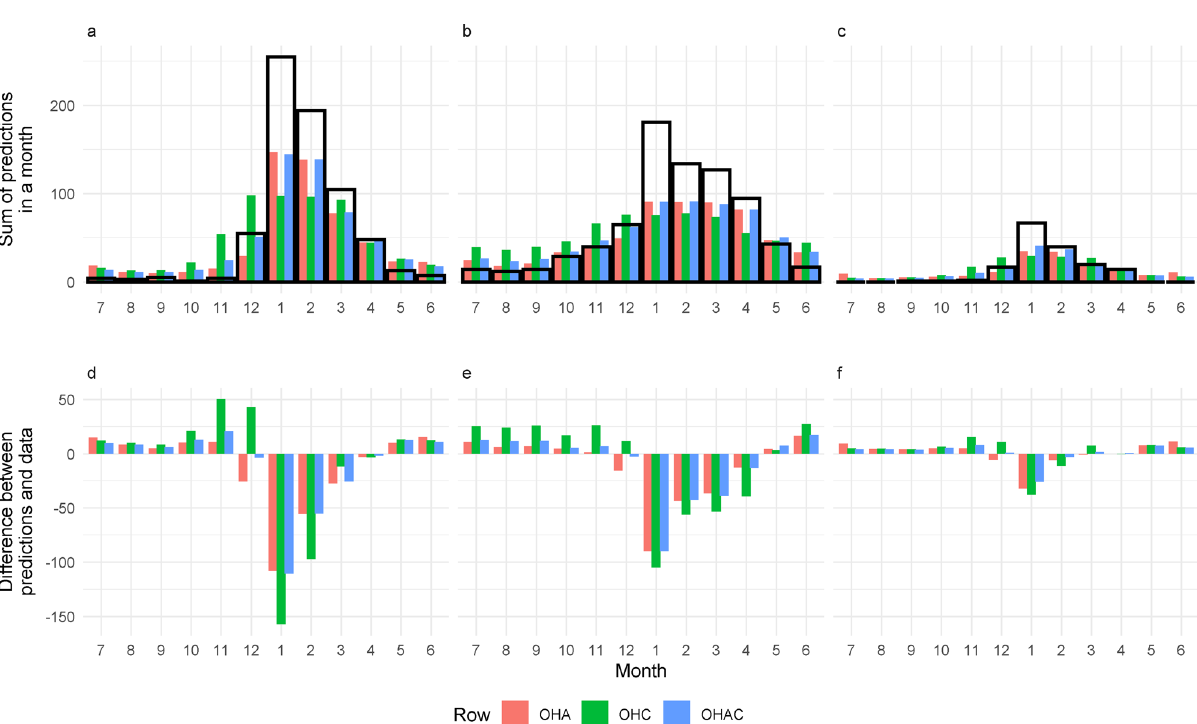
Fig. 3 Comparison of monthly model predictions and the data for models including seasonality of climate, agriculture and both. Total monthly YF reports and in-sample model predictions A, D for humans, B, E NHPs and C, F both classi fi cations. The top row ( A, B, C ) depicts the overall monthly data and model predictions for each classi fi cation type. The black rectangles indicate the data. The bottom row ( D, E, F ) show the residuals. Results are shown for the best fi t model including agricultural (but not climate) seasonality (model OHA), climate (but not agricultural) seasonality (model OHC) and both forms of seasonality (model OHAC). Within-sample predictions are shown. Red refers to the OHA model predictions, green the OHC and blue the